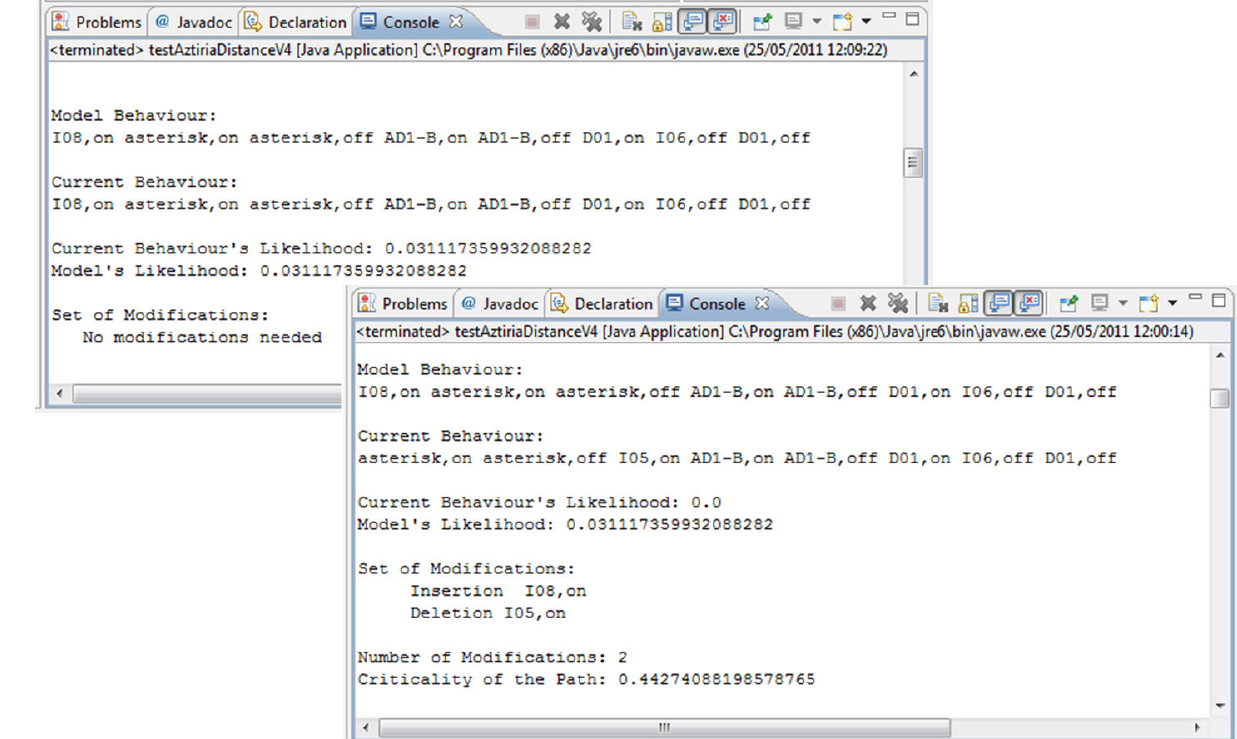
Figure 4. Example of outputs obtained in the validation